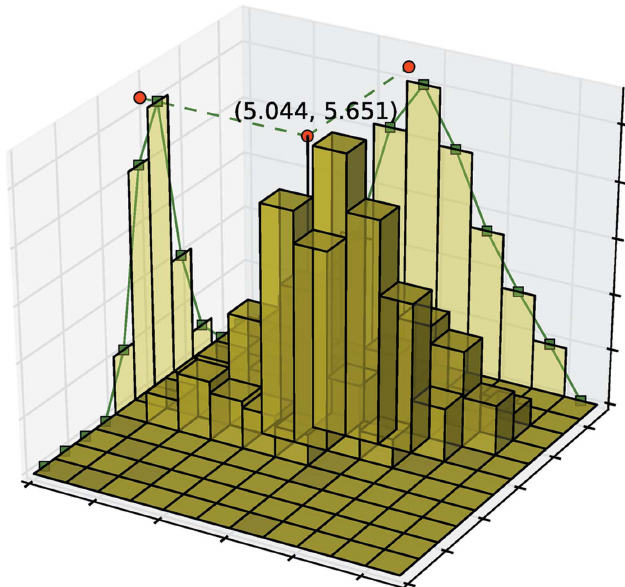
Figure 1 Diffraction peak in X-ray diffraction (11 (cid:3) 11 patch). The height denotes photon counts, and the red dots show the peak position computed by fitting a pseudo-Voigt